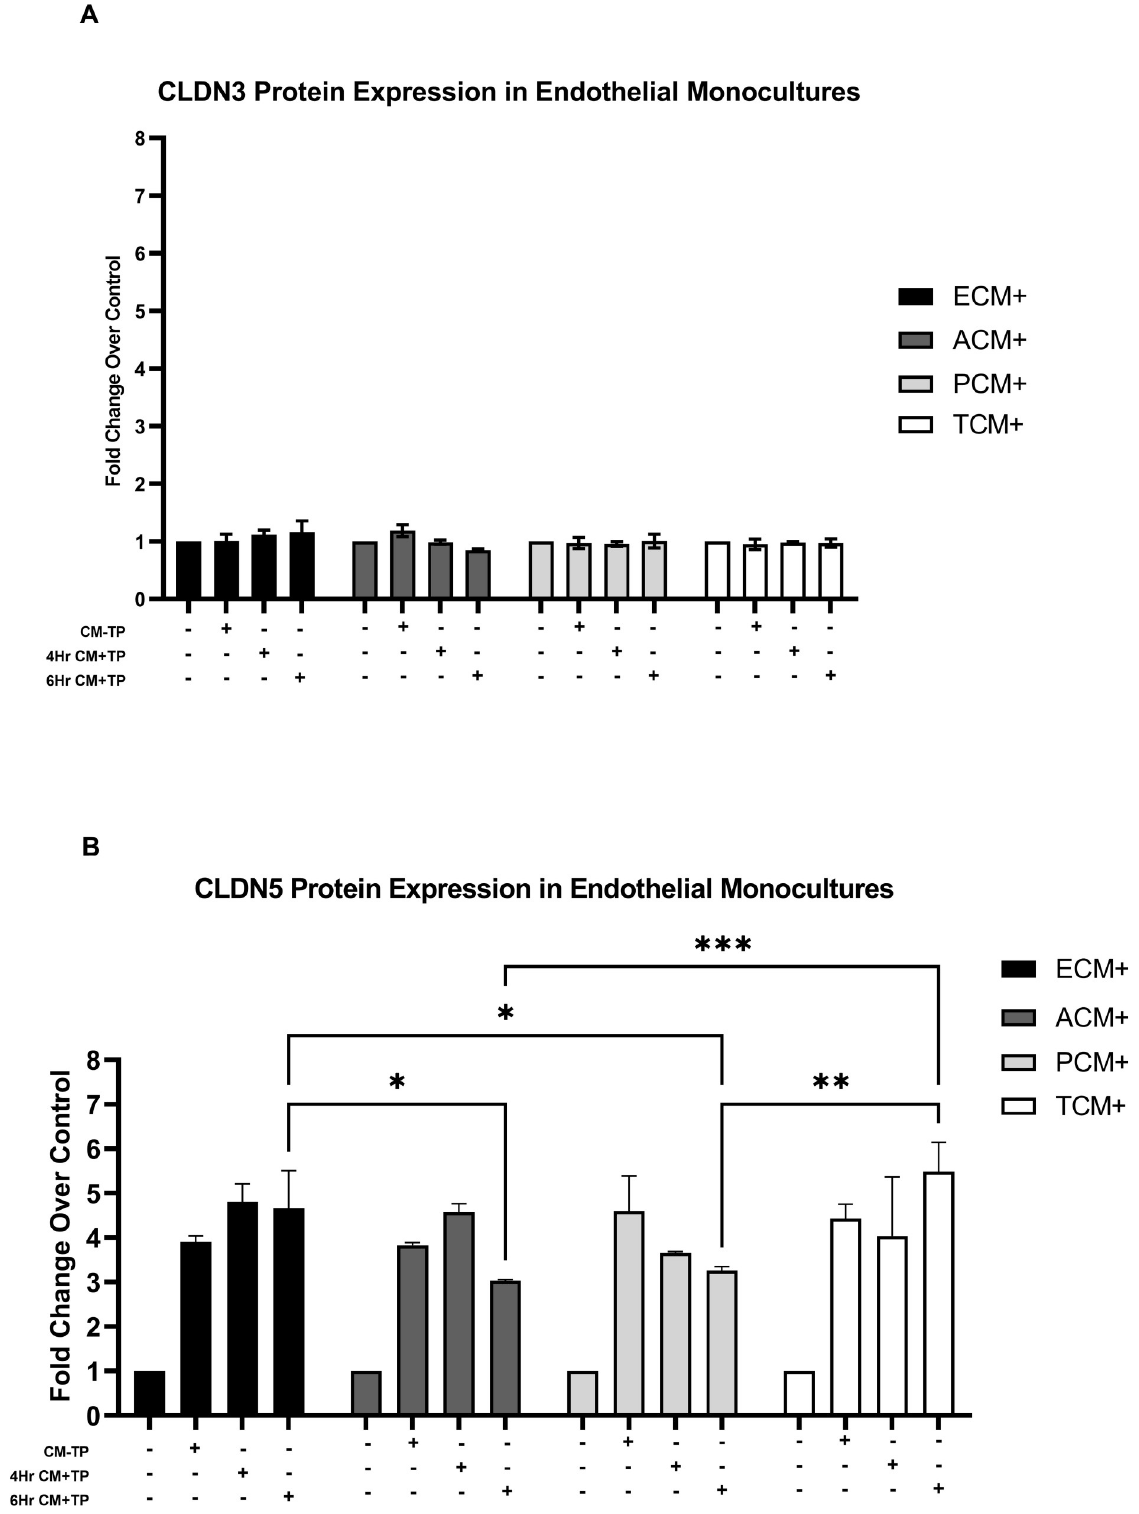
Fig 4. CLDN3 and CLDN5 protein expression in endothelial cell monocultures following a transfer of conditioned. Endothelial Monoculture Conditioned Media, (ECM+), Astrocyte Monoculture Conditioned Media, (ACM+), Pericyte Monoculture